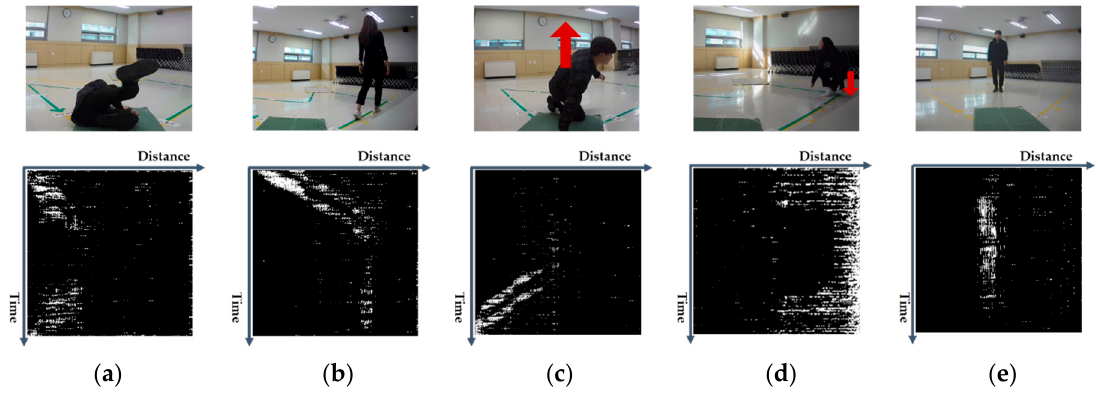
Figure 13. Results of motion image visualization: ( a ) fall, ( b ) walk, ( c ) rise, ( d ) sit, ( e ) stand.